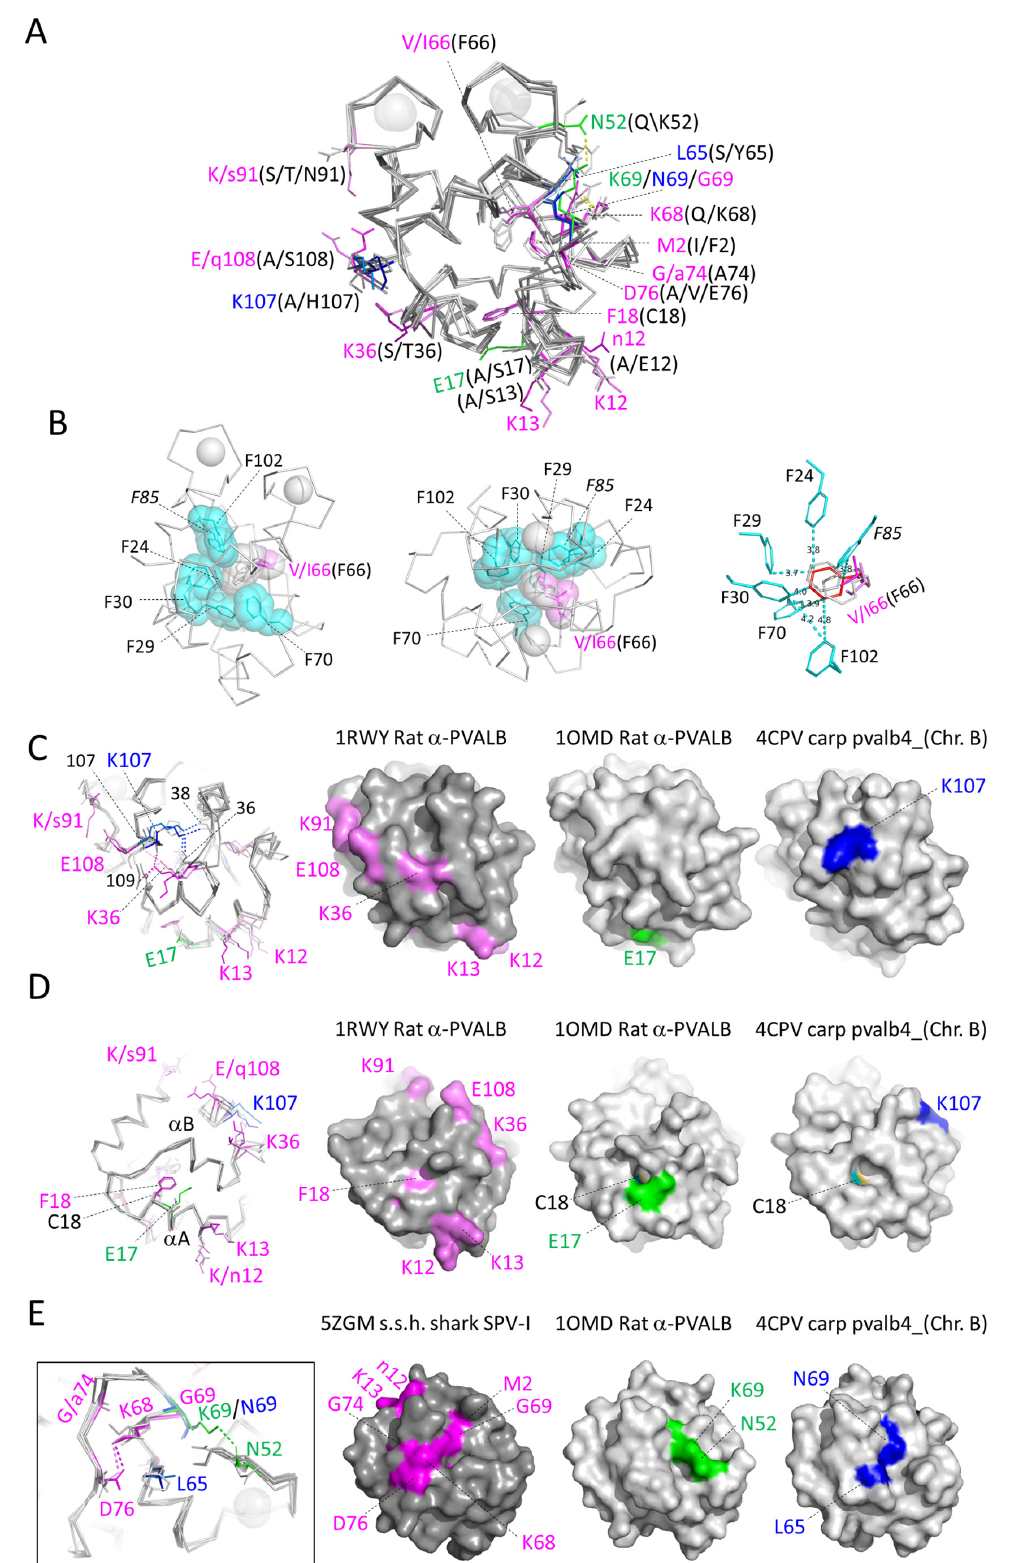
Figure 9. Structural locations of residues that are rather characteristic for the α -parvalbumins, oncomodulins, or other parvalbumins. Sidechains of residues at positions with category-specific features are shown in sticks format, in color when they are category-specific and otherwise in